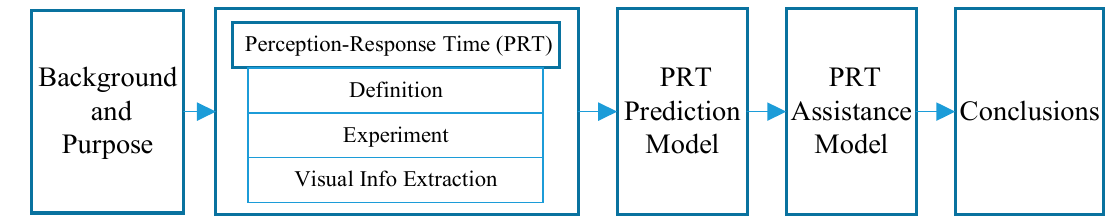
Figure 1. Workflow of the research.